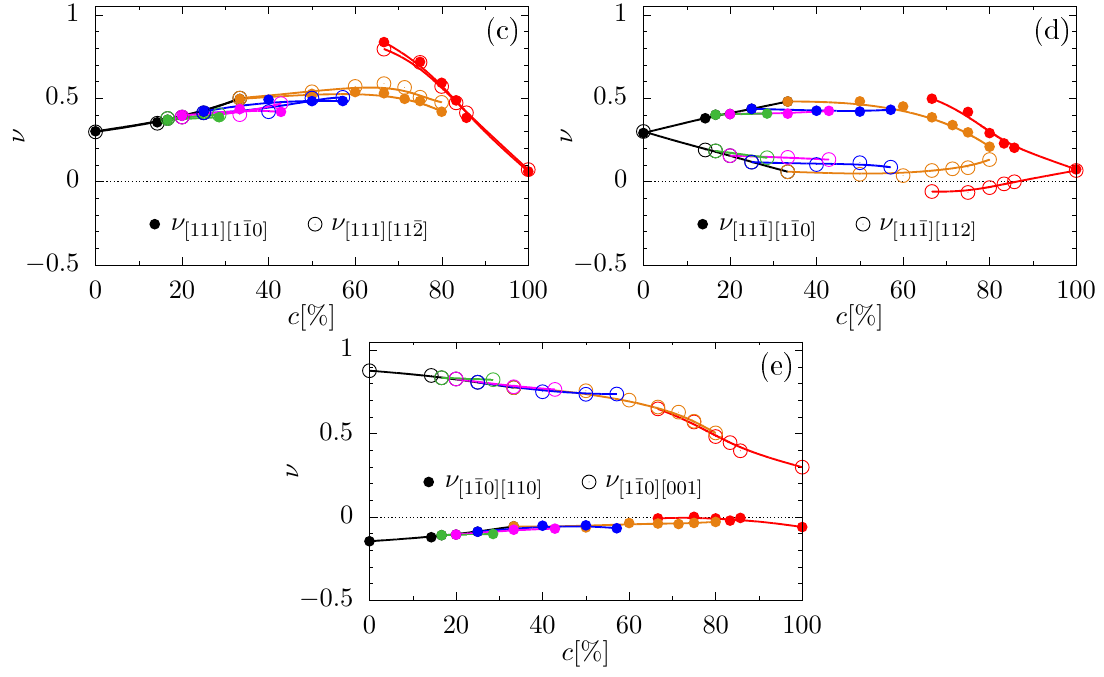
Figure 3. Poisson’s ratio in the main crystallographic directions versus concentration of particles of nanolayers in the studied system. The deformation of the system is applied respectively in the direction: